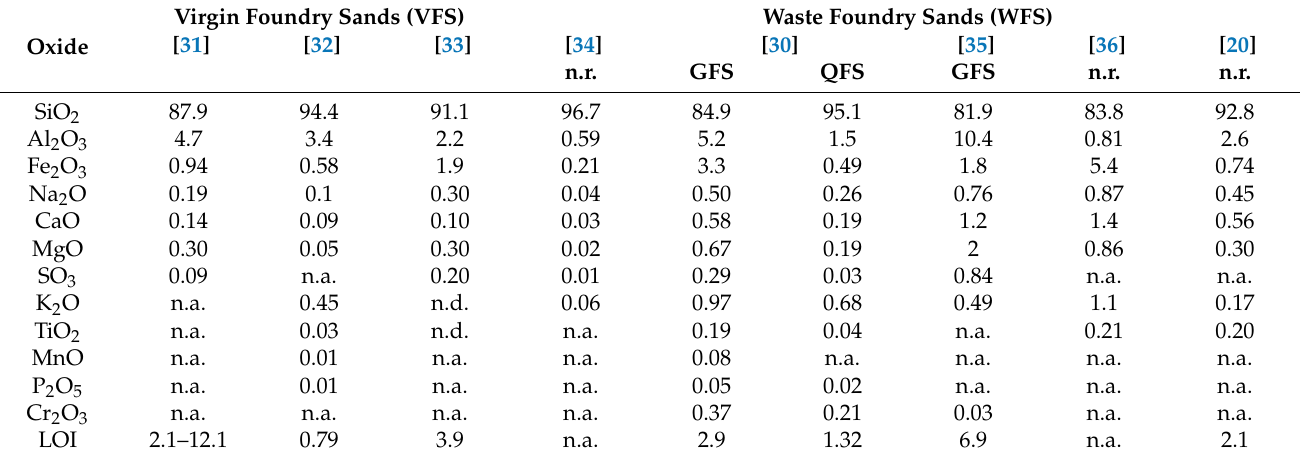
Table 1. Chemical composition (expressed in %) of virgin foundry sands (VFS) and waste foundry sands